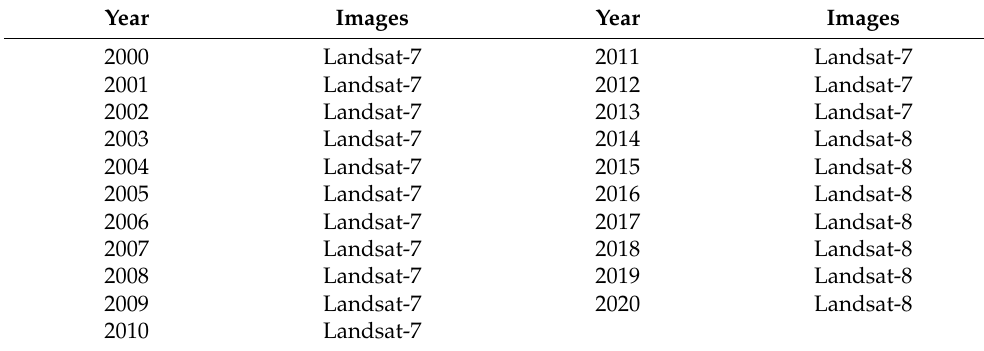
Table 3. Input Landsat images for two decades analysis.